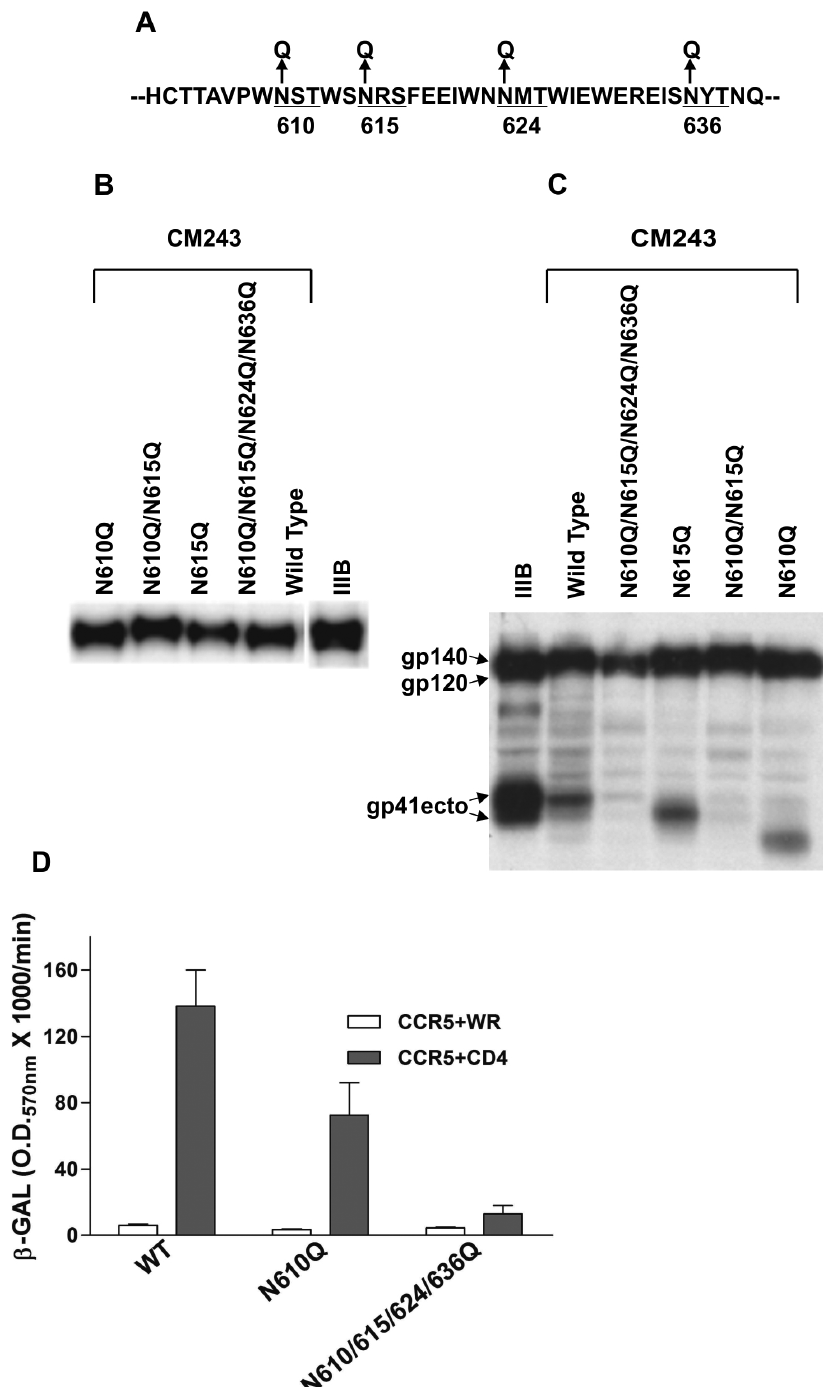
Figure 1. Deglycosylation mutants of HIV-1 strain CM243 gp140 Env. Panel A: Locations of point mutations in the gp41 ectodomain coding sequence that eliminate potential N-linked glycosylation sites. Panel B: Reduced SDS-PAGEanalysis of selected mutants of immunoprecipitated metabolically-labeled CM243 gp140 envelope glycoproteins using polyclonal rabbit antisera. Glycoproteins were transiently expressed in cells by plasmid transfection and infection with recombinant vaccinia viruses. Panel C: Analysis of precursor processing of metabolically-labeled CM243 gp140 wild type and glycosylation mutants by immunoprecipitation and reduced SDS-PAGEanalysis using a gp41 specific mAb (D61). Arrows point to gp41 ectodomains. Wild type CM243, single mutant N610Q and N615Q were processed to gp120 and gp41 ectodomain subunits. Where processing was evident the single N610Q resulted in the largest shift in apparent molecular weight of the gp41 ectodomain, an approximately 5–6 kDa loss. Panel D: Cell-cell fusion activity of selected CM243 mutants and wild type full length Envs using the b -gal reporter gene assay in transient transfected expressed constructs.